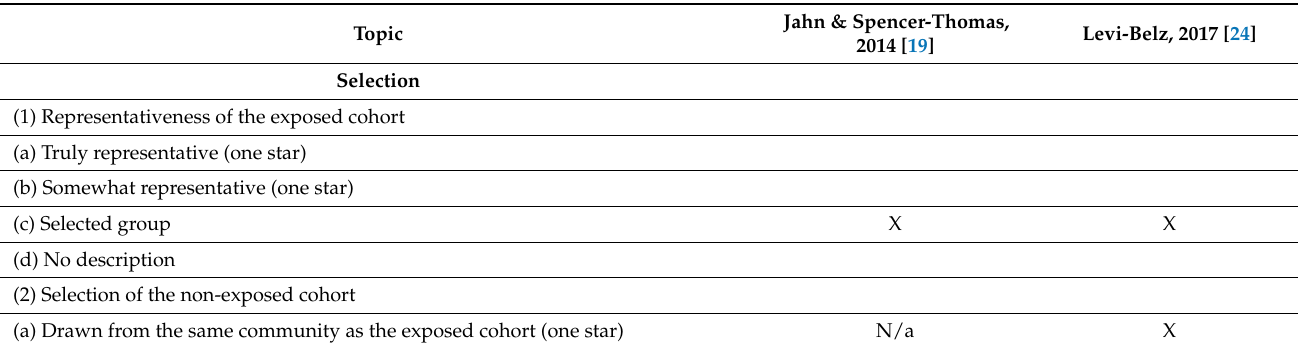
Table A1. Quality assessment 1 of quantitative